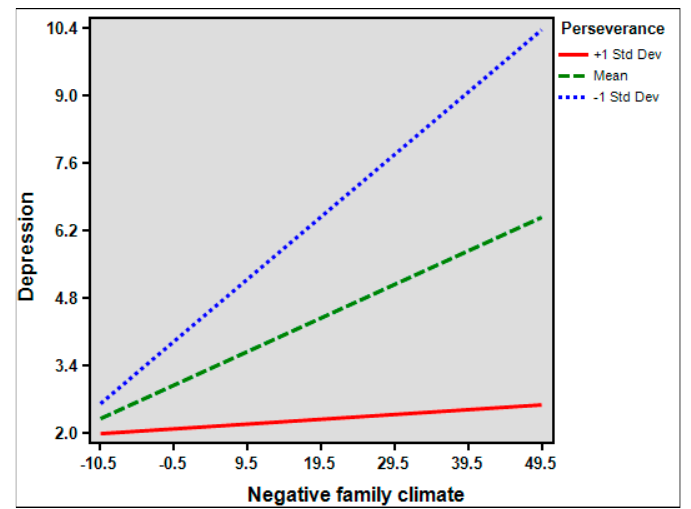
Figure 1. Depression scores as a function of the interaction between Negative Family Climate and perseverance.